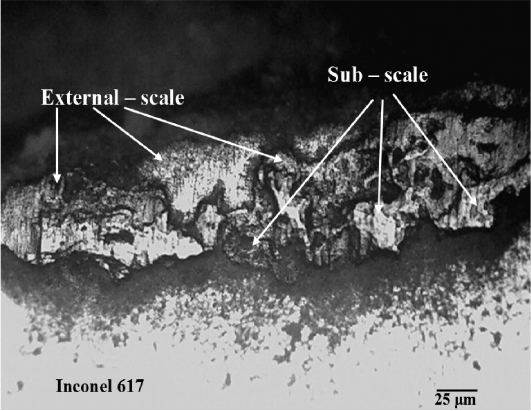
Fig. 5: Optical image of the oxide layer on the surface of Inconel 617 with external-scale and sub-scale